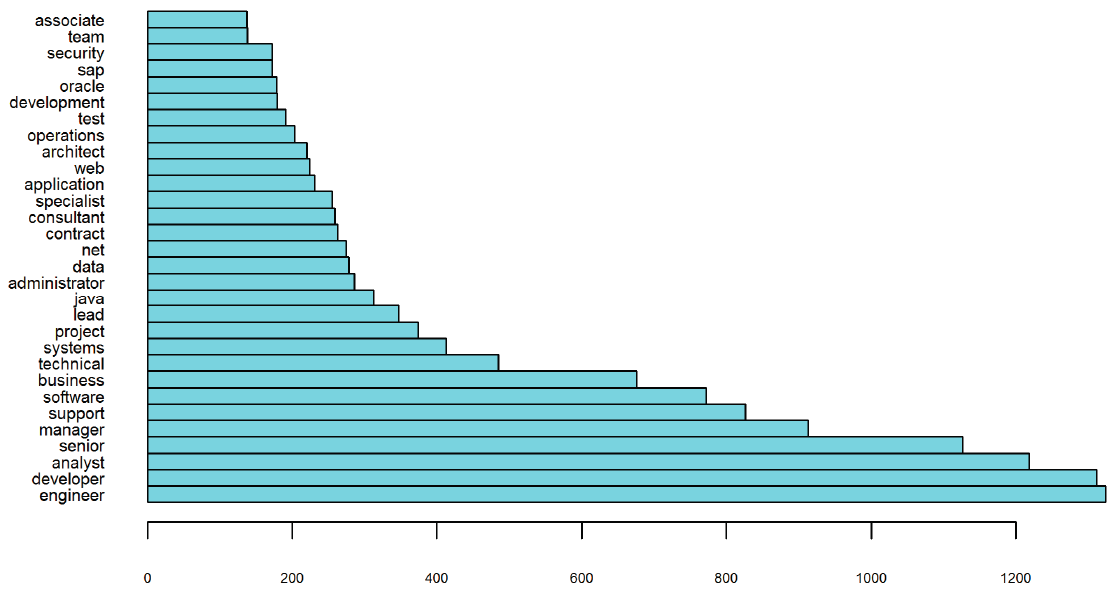
Figure 3. Top 30 terms—IT dataset (JobTitle).